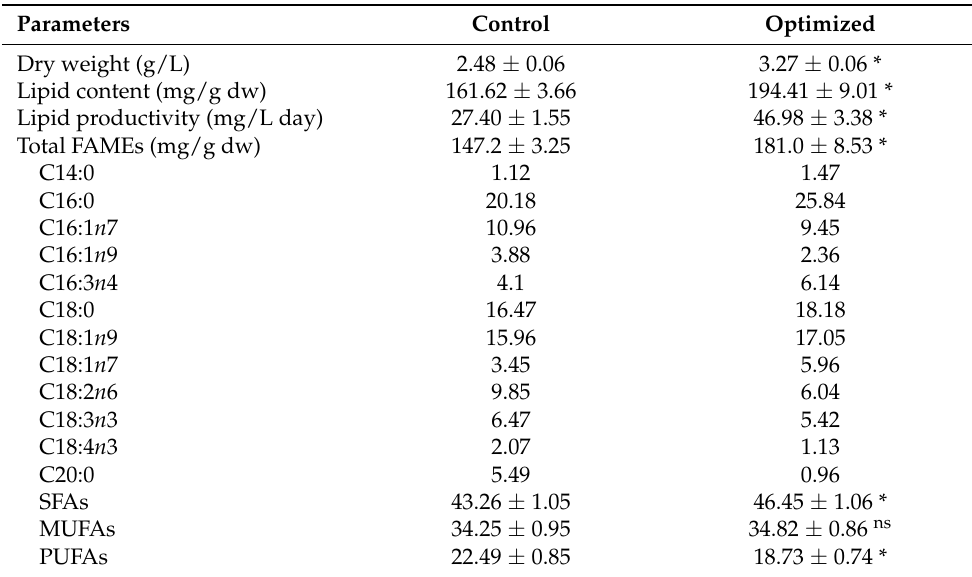
Table 4. Biomass, lipid production, and fatty acid profile of Chlorella sp. grown under optimized conditions in comparison with the